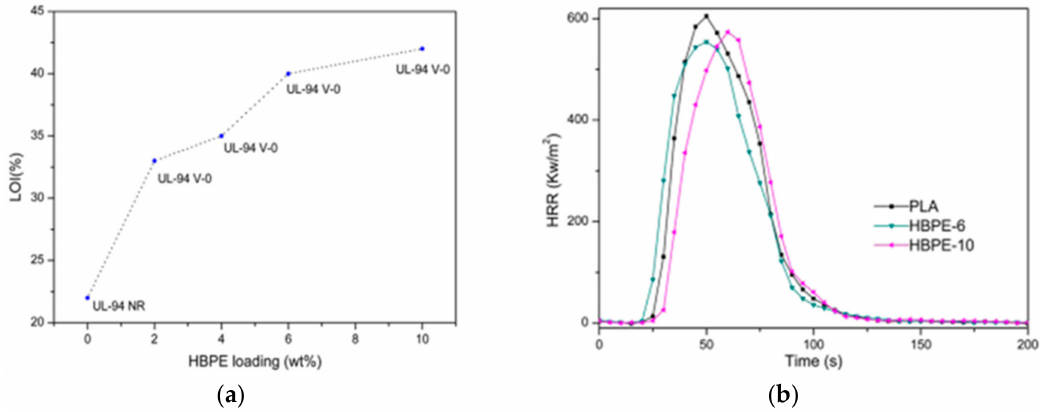
Figure 10. ( a ) LOI/UL-94 and ( b ) PHRR results of PLA/HBPE and composites (Adapted with permission from